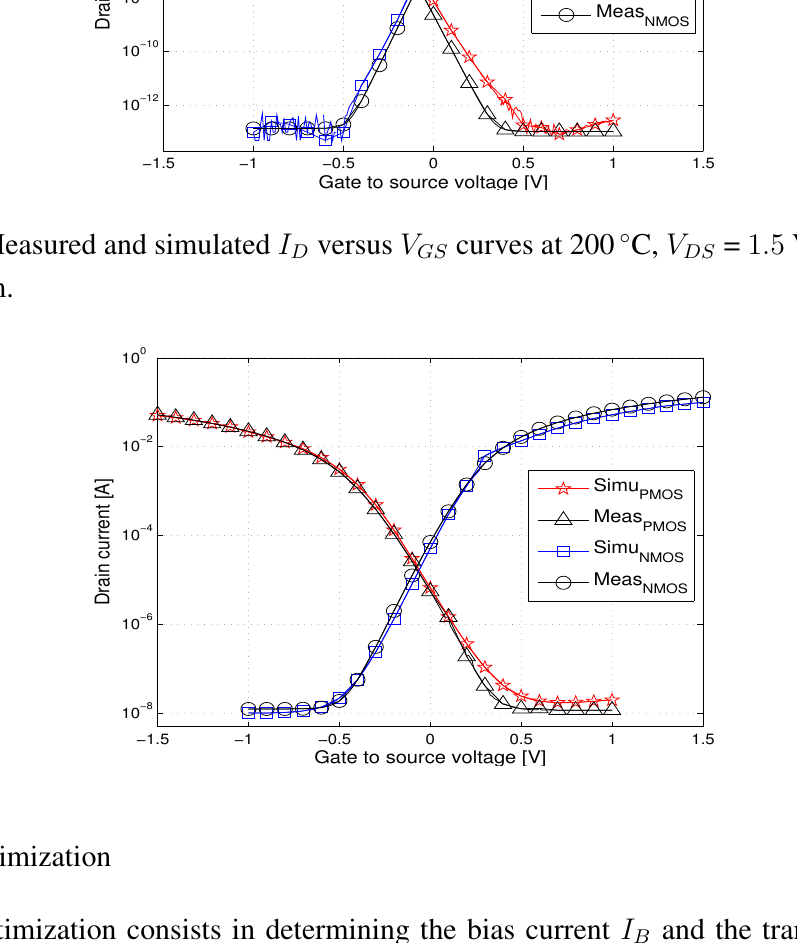
= 1 . 5 V, W = 1 µ m, DS